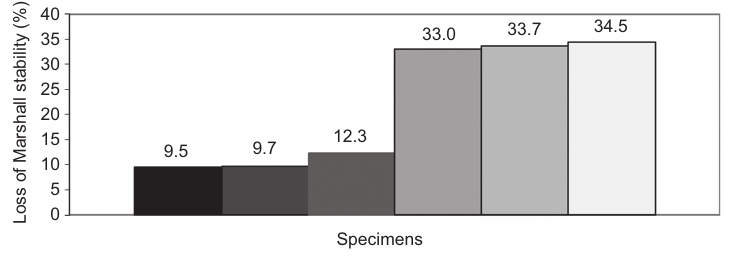
Figure 11 Mechanical Marshall immersion test results.